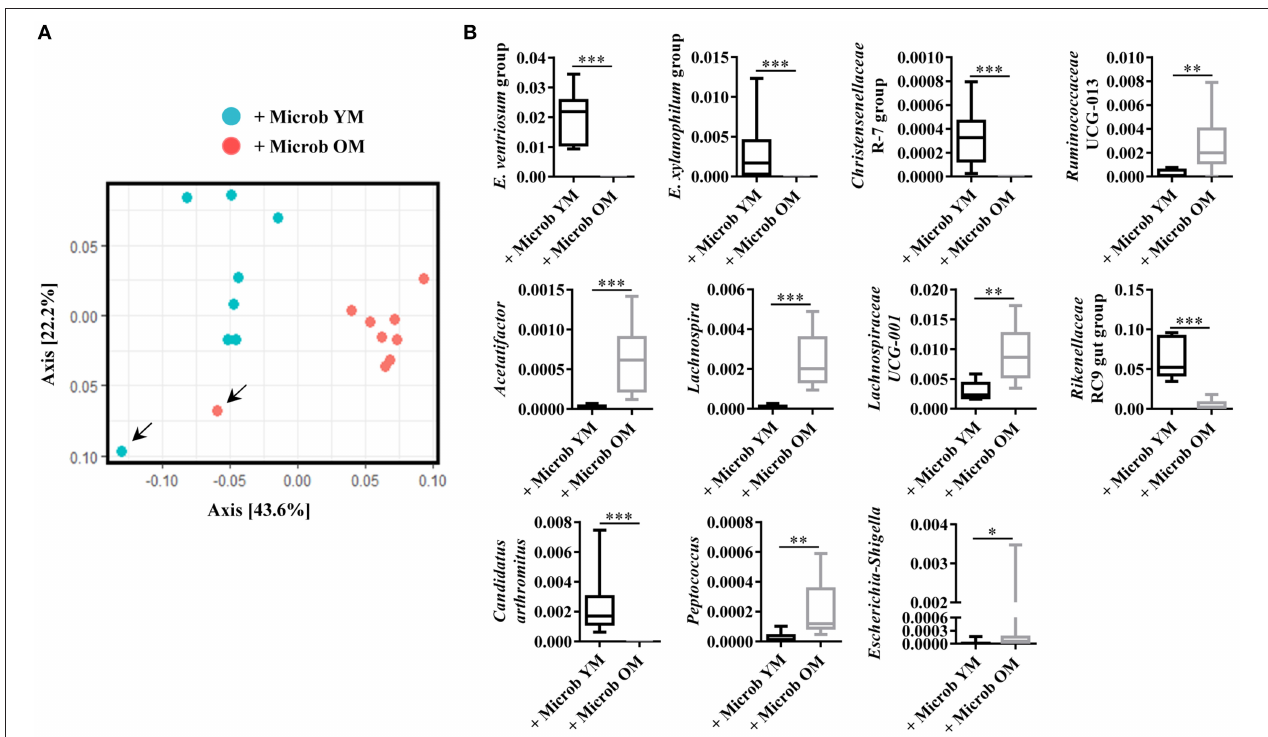
FIGURE 1 | Microbiota analysis in recipient germ-free mice. (A) Composition of the fecal microbiota analyzed by Unifrac distance. Each dot represents one mouse. Blue dots represent fecal microbiota from germ-free mice ( n = 7) inoculated with feces of conventionally raised young mice ( + Microb YM) and red dots represent fecal microbiota of germ-free mice ( n = 8) inoculated with feces from conventionally raised old mice ( + Microb OM). Arrows indicate donors. (B) Relative abundance in percentage of genus significantly modified in fecal microbiota of mice inoculated with feces from young mice and of mice inoculated with feces from old mice. E. ventriosum group: [ Eubacterium ] ventriosum group, and E. xylanophilum group: [ Eubacterium ] xylanophilum group. Comparisons were done between the two groups of mice ( + Microb YM and + Microb OM). * p < 0.05, ** p < 0.01 and *** p <